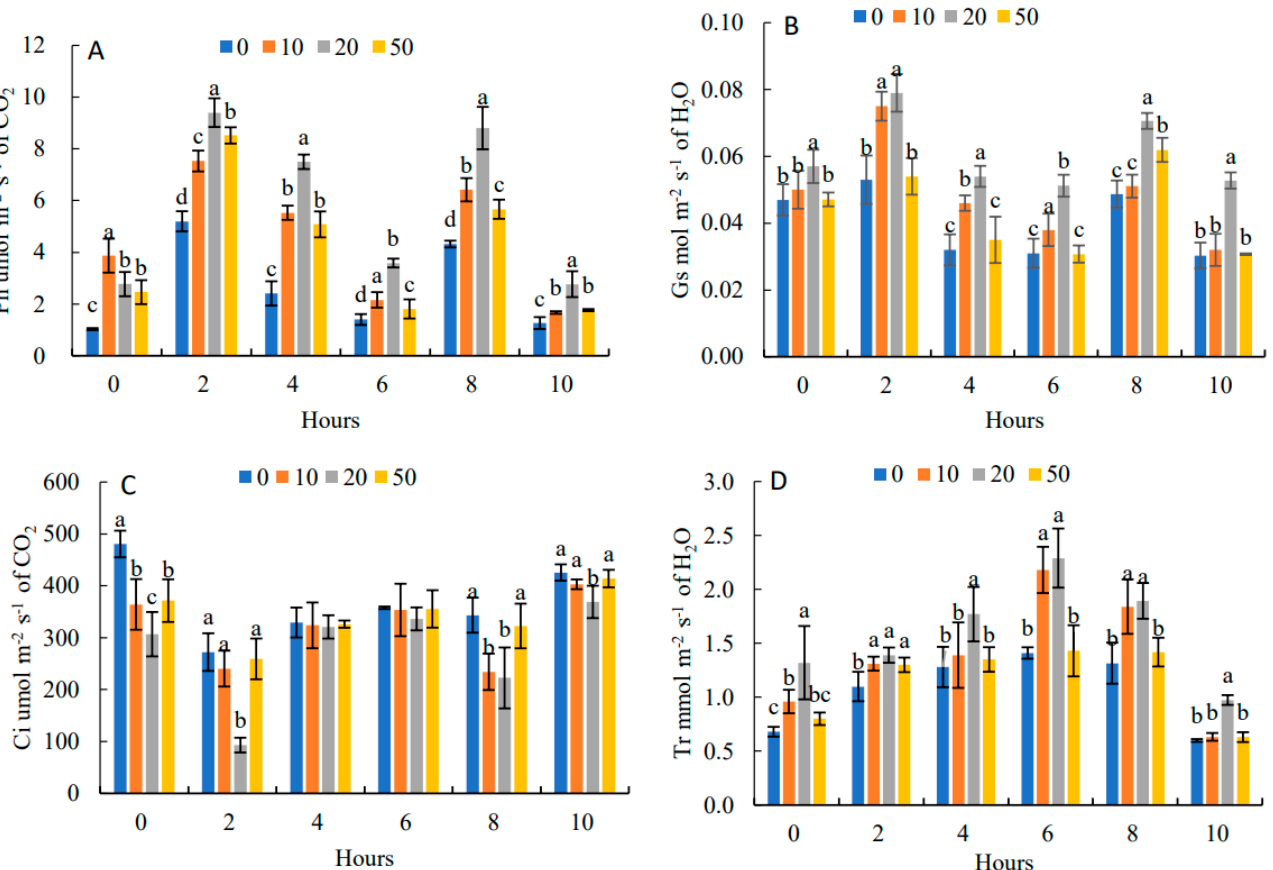
Figure 4. Effects of 5-ALA on diurnal changes of net photosynthetic rate (Pn) ( A ), stomatal conduct- ance (Gs) ( B ), intercellular carbon dioxide concentration (Ci) ( C ) and transpiration rate (Tr) ( D ) of P. heterophylla in 10 h (from 7:00 to 17:00) . Data show the mean with standard deviation bar of three replicates from samples. Different letters indicate a significant difference at 0.05 level between dif- ferent treatments.